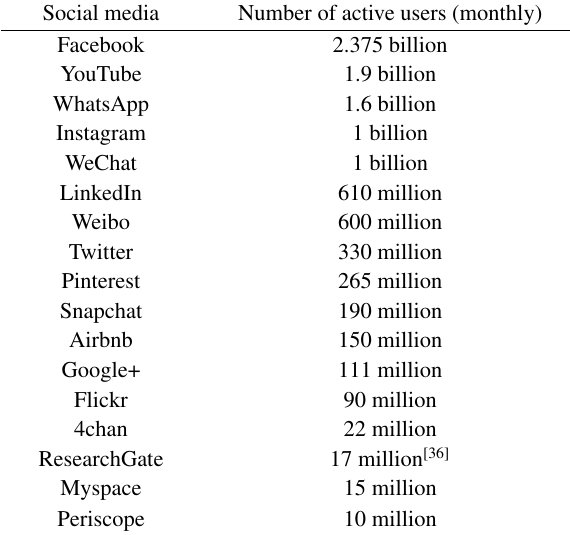
Table 3 Statistic of active users in social